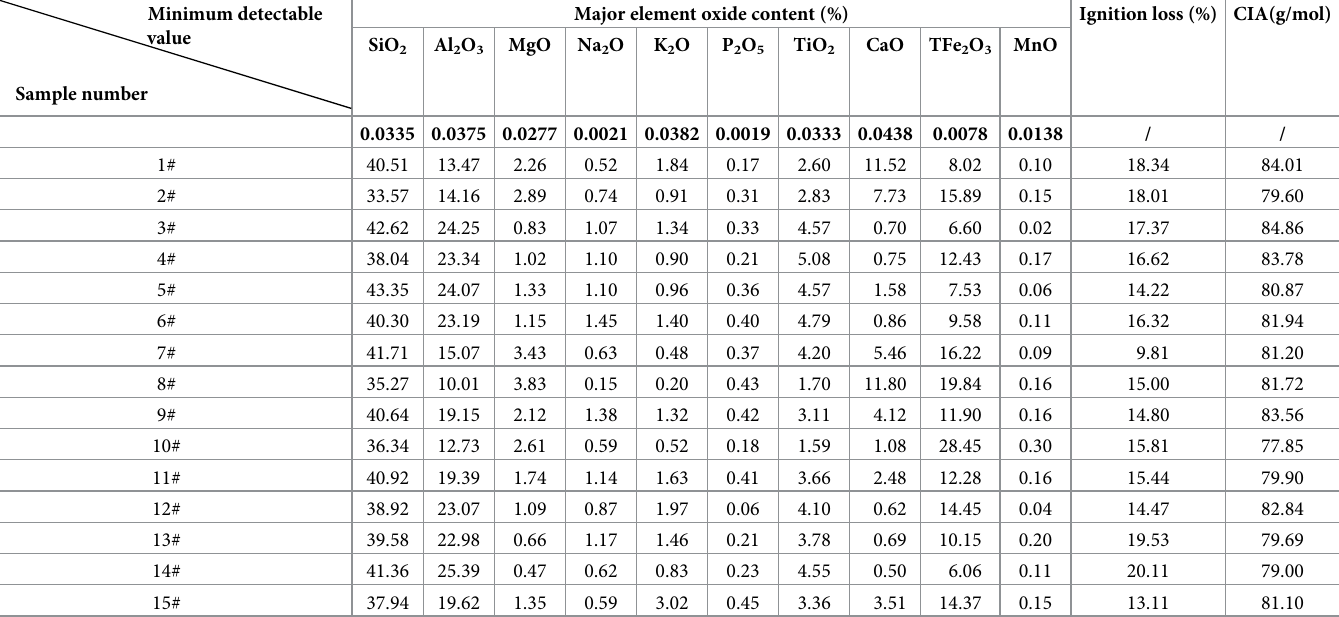
Table 3. Major element oxide contents of different samples from the Longtan Formation in the study area.